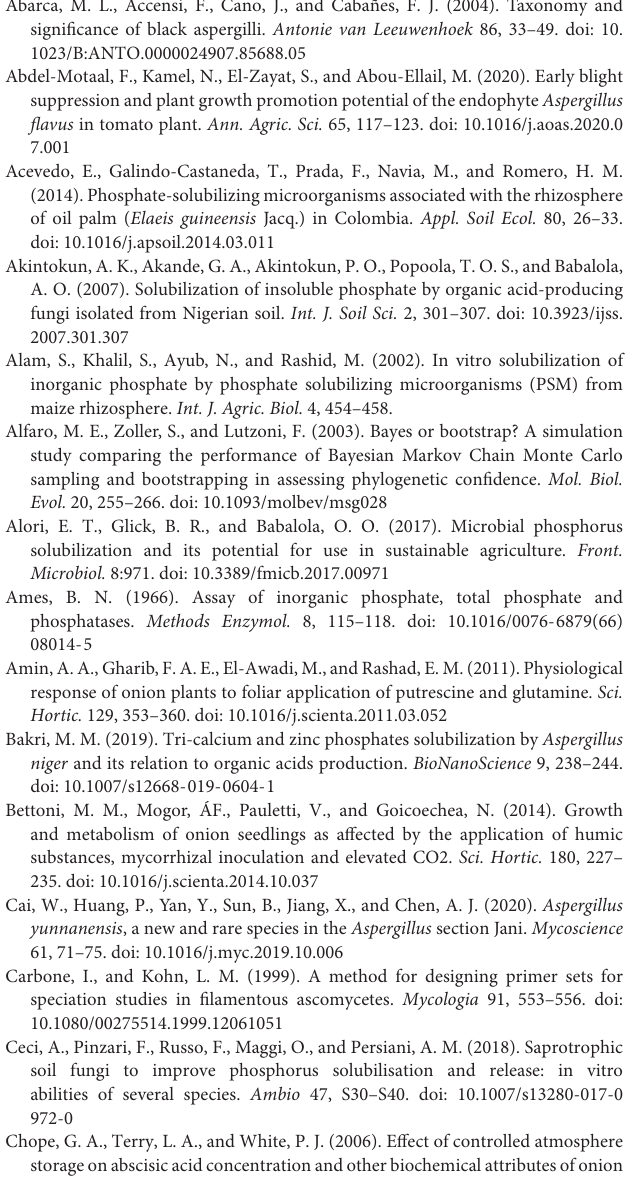
Supplementary Table 3 | Microscopic characteristics of biseriate species of Aspergillus section Nigri